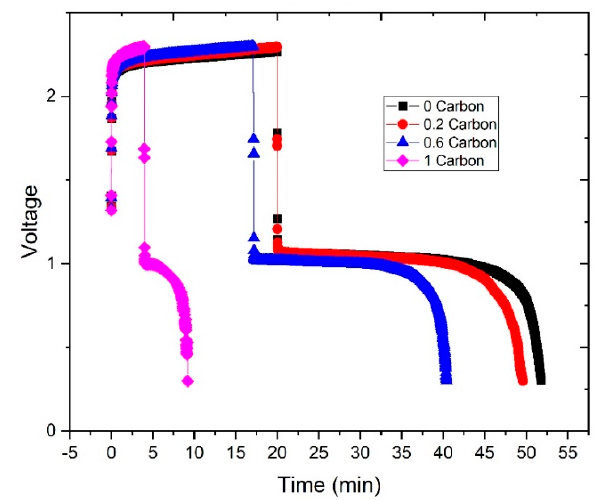
Figure 8. Charge-discharge curves to estimate zinc plating on the bipolar plate: charge with each zinc slurry and discharge after replacing the slurry with 10 M KOH.